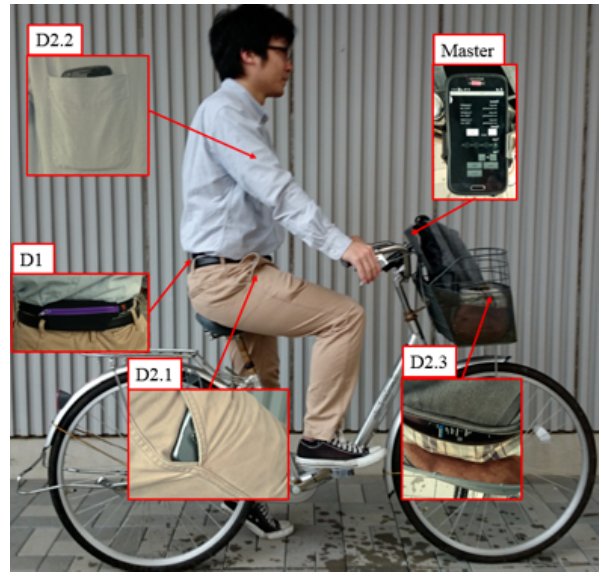
Figure 1: The experimental